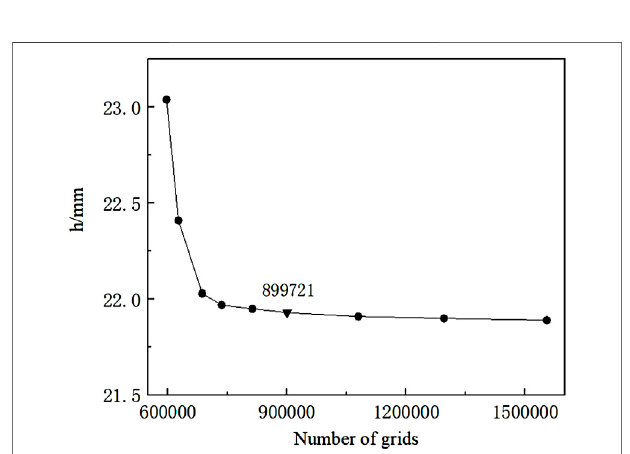
FIGURE 10 | Diagrams of hydraulic loss under different